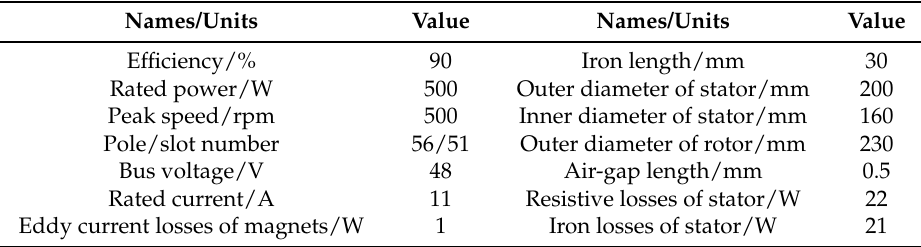
Table 2. Parameters of the